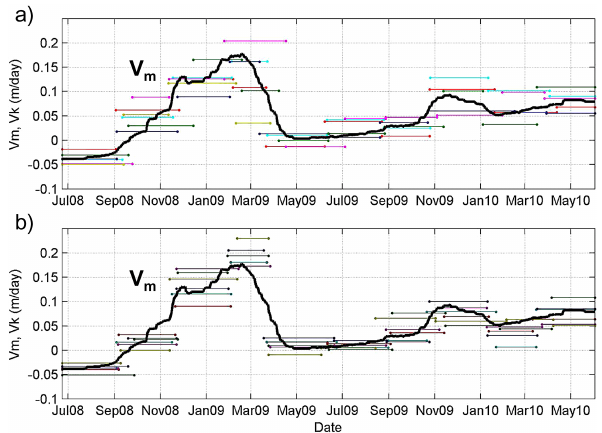
Figure 8. V m (thick black line), time-dependent migration rate of the entire bar system (average of all coloured lines). V k (colour lines), individual bar migration rate (the colours correspond to Fig. 6). (a) V k for bars 3–8. (b) V k for bars 9–14.